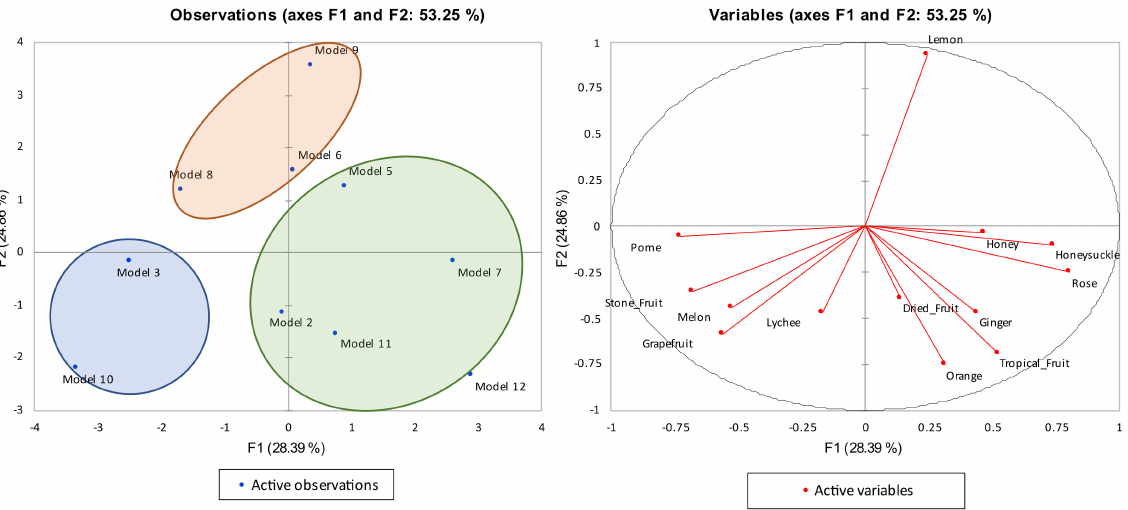
Figure 2. Separation of wines models by monoterpene profile using PCA; circles represented the clusters obtained from